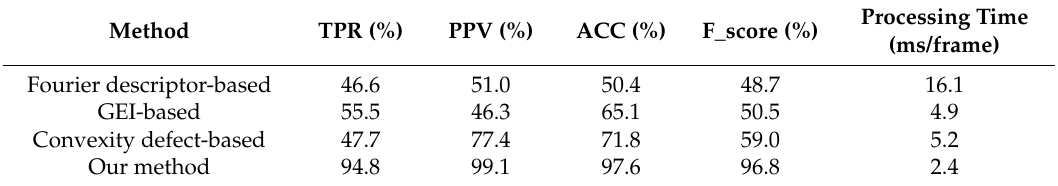
Table 9. Summarized comparisons of accuracies and processing time obtained by previous methods and by our